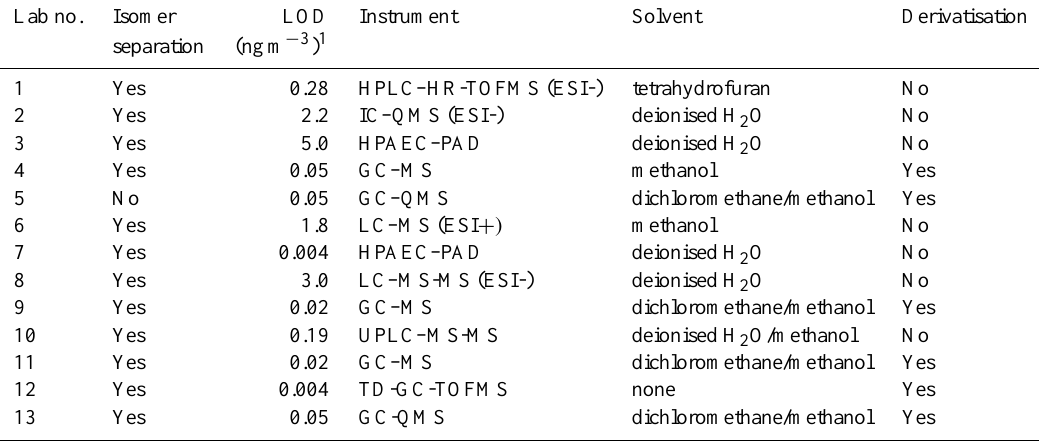
Table 1. Overview and short description of the analytical methods used by the participating laboratories in the present intercomparison, including the method’s capability for isomer separation, the method’s limit of detection (LOD), the instrument used for separation and detection of the analytes, the solvent(s) used for extraction and whether derivatisation of the analytes was applied. Lab no. Isomer LOD Instrument Solvent Derivatisation separation (ngm − 3 ) 1 Yes 0.28 HPLC–HR-TOFMS (ESI-) tetrahydrofuran No Yes 2.2 IC–QMS (ESI-) deionised H 2